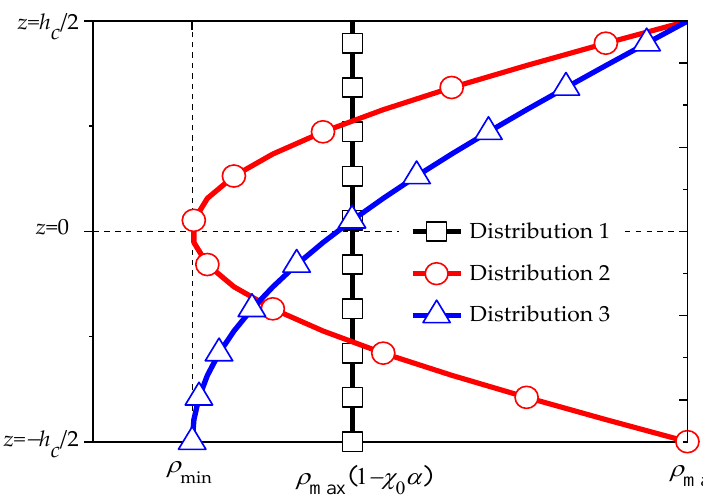
Figure 2. Material constants of three typical distributions. The approximate process of the governing equations and boundary conditions of the model obtained is shown in Figure 3.